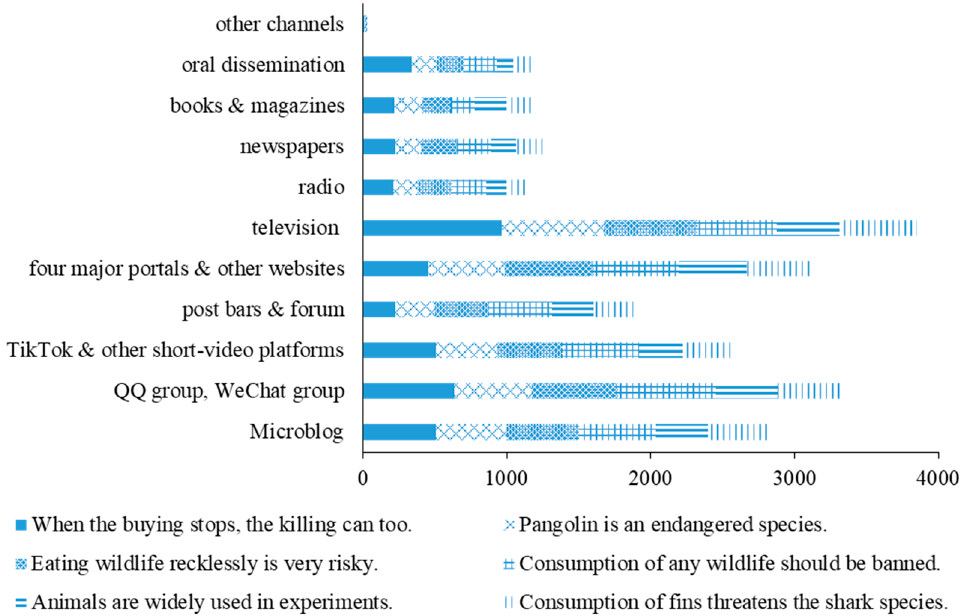
Figure 2. The channel through which respondents obtain information about the top 6 topics.